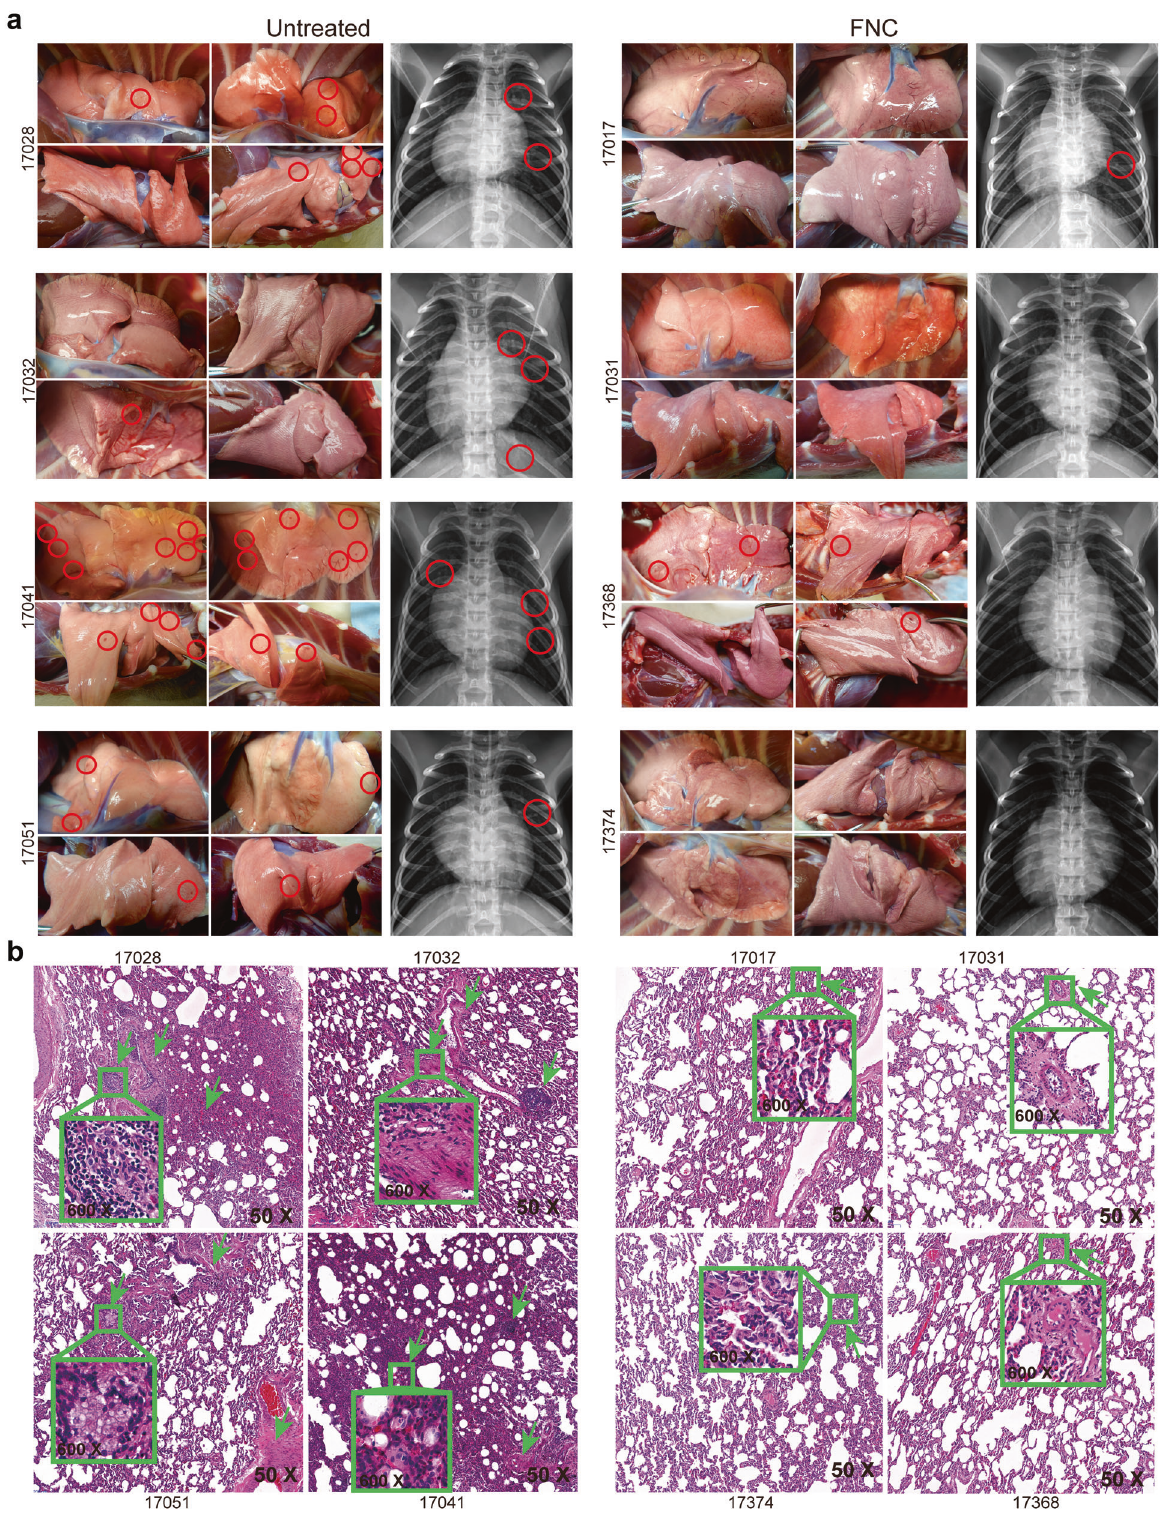
Fig. 4 FNC protected lung from SARS-CoV-2 infection. a left. FNC reduced petechial spots (red circle) in lung of virus ( + ) monkeys. a right. Chest X-ray images clearly showed the ground-glass shadows or light shadows in the untreated monkeys (red circle), but much less in the FNC-treated virus ( + ) monkeys. b HE staining of the lung tissues was done and evaluated. Lesions in the lung of the untreated virus ( + ) monkeys included interstitial in fi ltration of neutrocytes or monocytes or macrophage, thickening of alveolar septae and vessel wall, blood effusion, edema, and fi brin with hyaline membranes as well as damage in cell structures (see green arrows); treating the monkeys with FNC substantially reduced the lesion described above